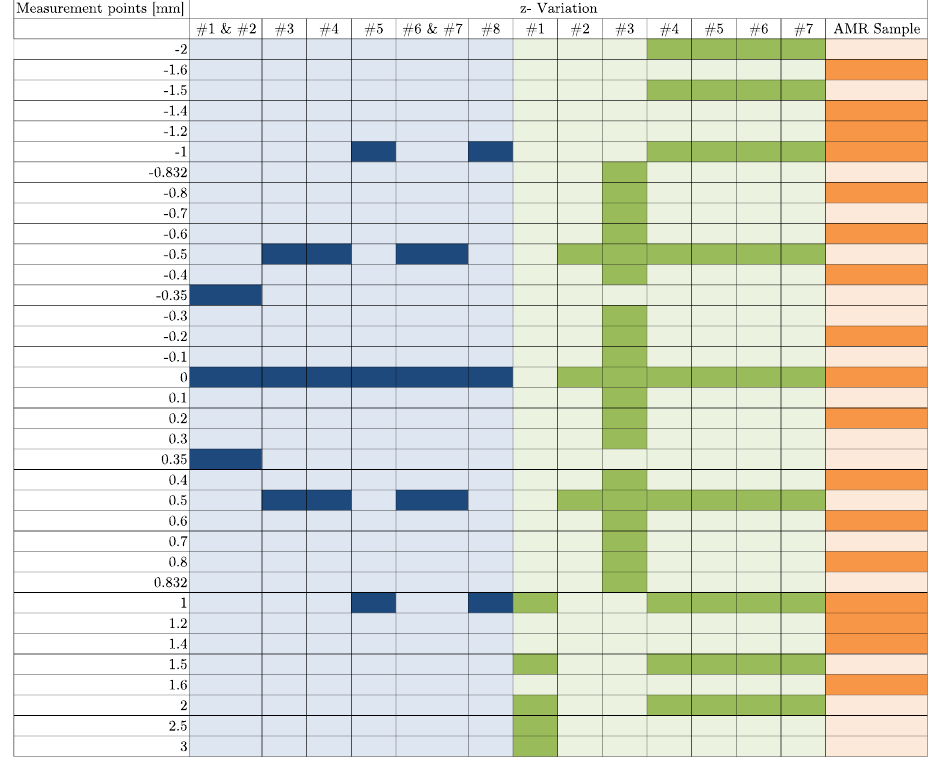
Figure A3. Measurement plan for the axial evaluation of all rotor position sensors; blue, resolvers; green, inductive sensors; orange, AMR sensor.